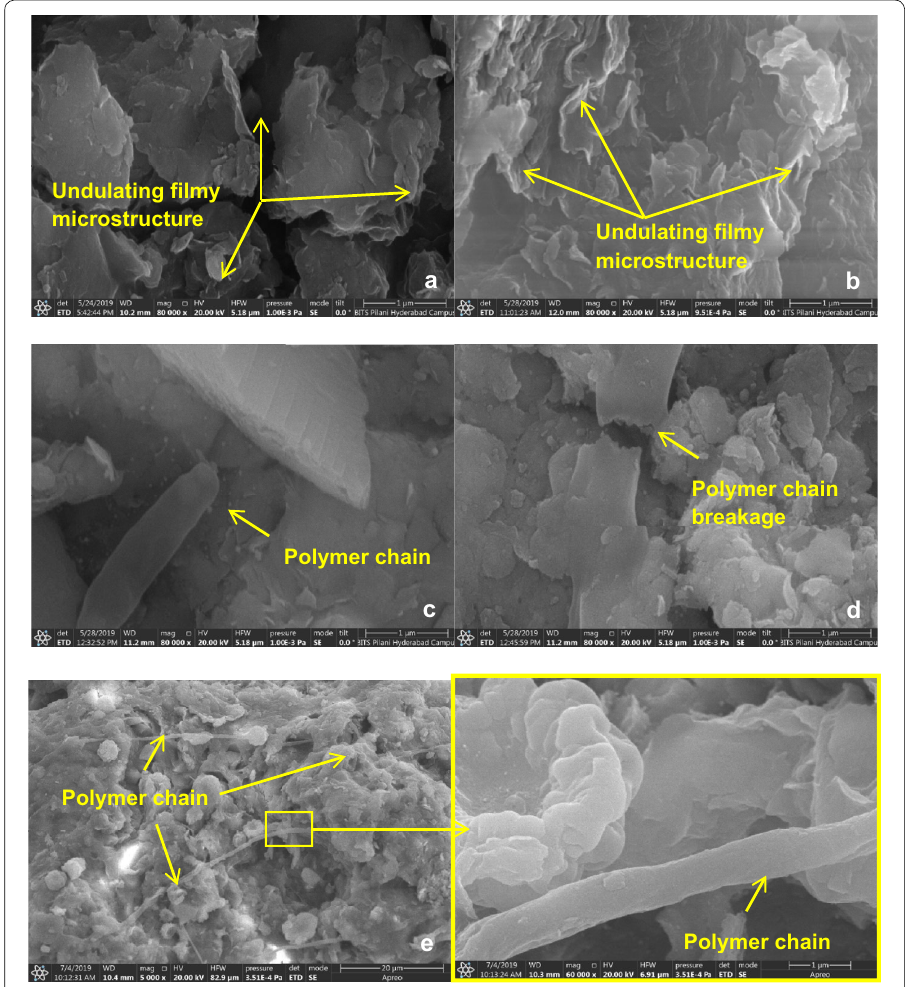
Fig. 4 SEM images of AMS treated with a 0% LS, b 0.5% LS, c 1% LS, d 2% LS, e 4%